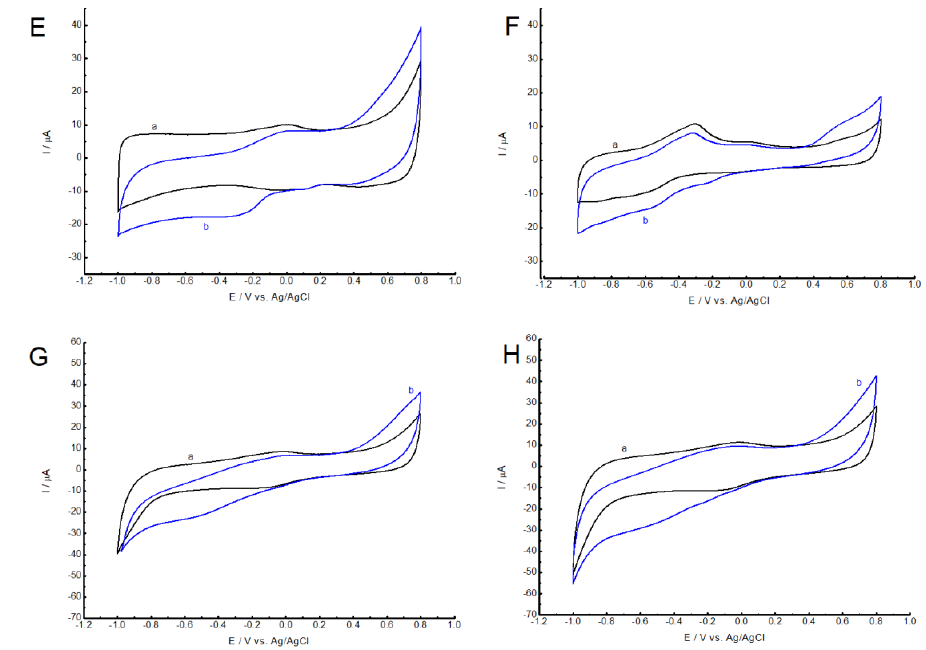
Figure 5. Cyclic voltammograms recorded for ( A ) bare GC, ( B ) GC/ Pz3 , ( C ) GC/MWCNTs, ( D ) GC/MWCNTs/ Pz3 , ( E ) GC/SWCNTs, ( F ) GC/SWCNTs/ Pz3 , ( G ) GC/rGO, and ( H ) GC/rGO/ Pz3 . Experiments were performed in a phosphate buffer (pH 7.4) before (a, black line) and after (b, blue line) adding 2 mMof hydrogen peroxide. A scan rate of 10 mV s − 1 was